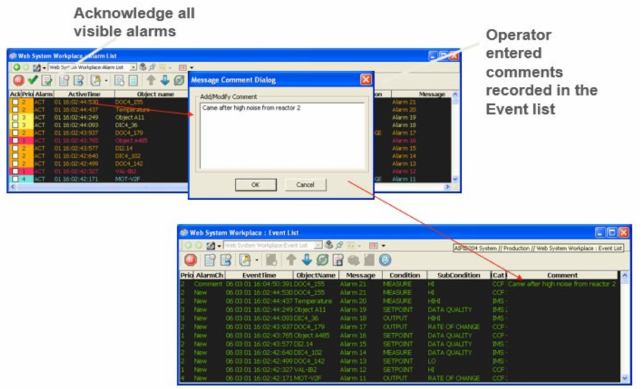
Figure 10. DCS alarm features for alarm display and event